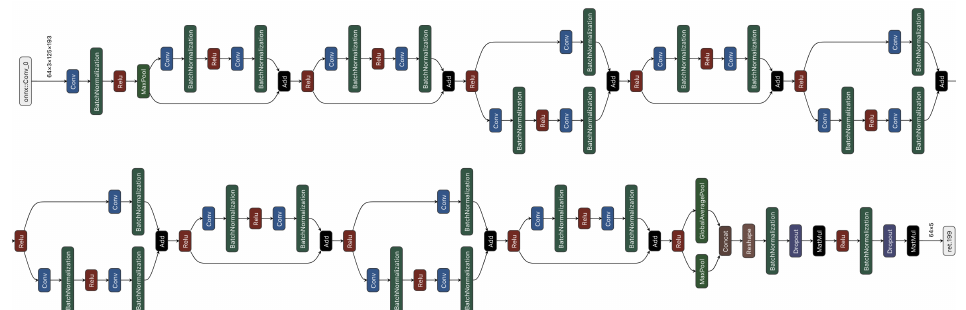
Figure 11. Overview of the ResNet18 architecture. Note that data flows from left to right and from top to bottom. The colored boxes represent the following components: blue = Convolutional layer , red = ReLU layer , green = Batch Normalization or Max Pooling layer , and white = Input/Output layer .